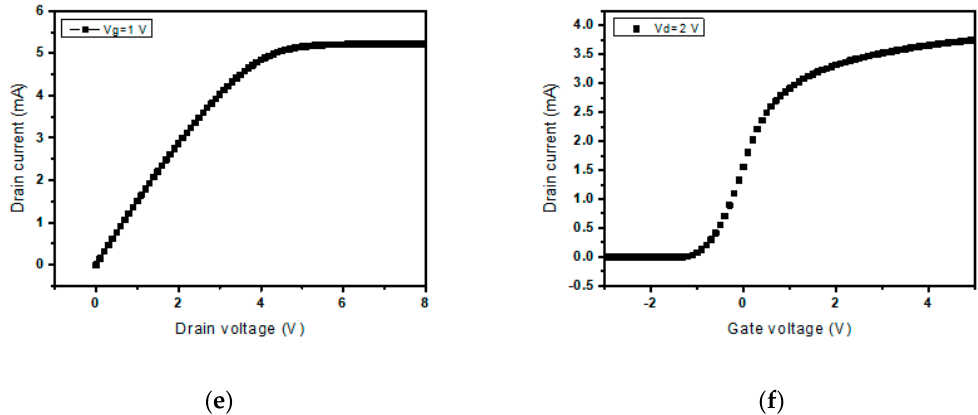
Figure 1. ( a ) Schematic representation of circuit implemented as sensor detection system; ( b ) Real world model of the device implanted; ( c ) plot of drain current to the voltage across the drain-source terminal; ( d ) graph of output drain current to the input gate voltage of the extended gate field effect transistor (FET) sensor; ( e ) output characteristics of LND 150; ( f ) transfer characteristics of LND 150.